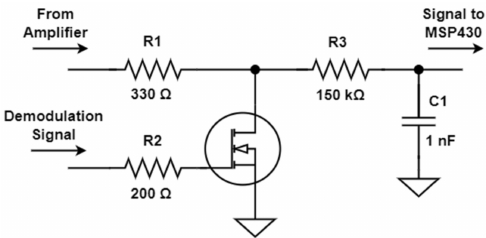
Figure 10. Minimalist demodulator circuit schematics.